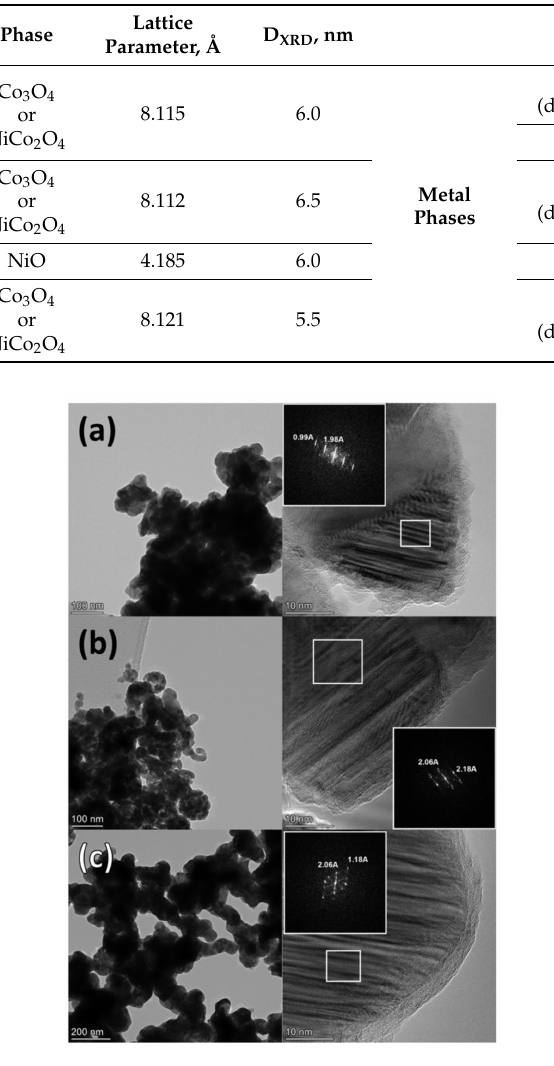
Figure 3. XRD patterns of Co2Ni1 samples obtained with different water content after calcination ( I ) and reduction ( II ): Co2Ni1_W0 ( a ); Co2Ni1_W4 ( b ); Co2Ni1_W8 ( c ). Table 2. Phase composition, lattice parameters, and DXRD size of Co-Ni-containing samples after calcination and reduction.